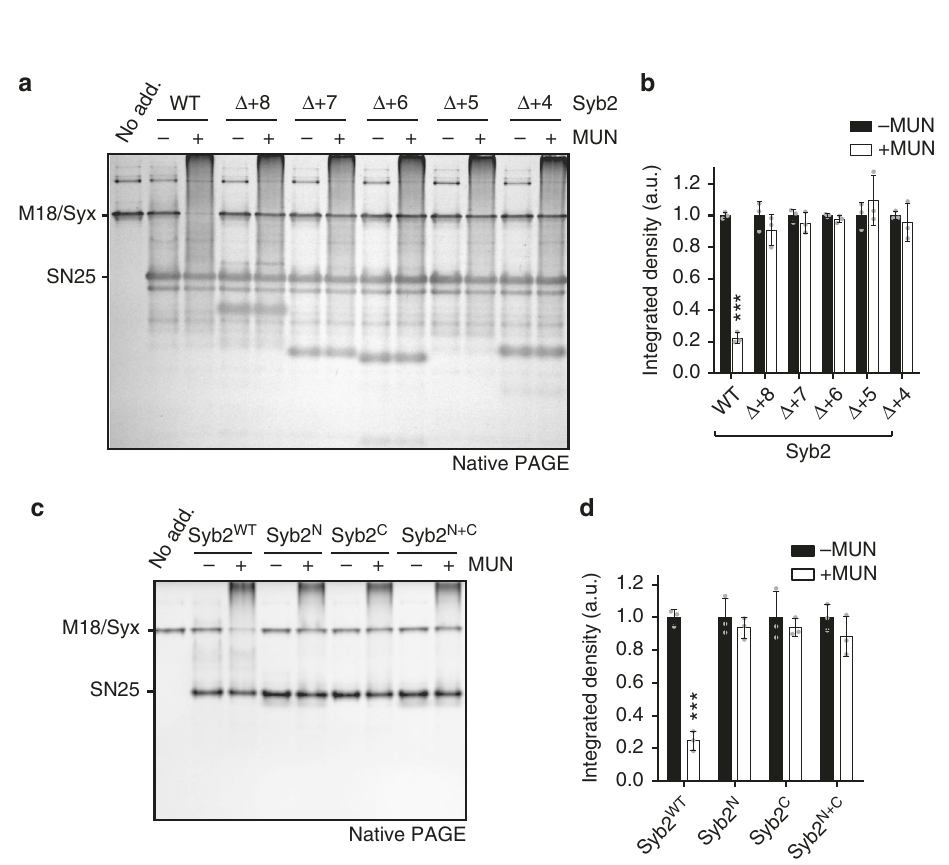
Fig. 1 A half-zippered SNARE assembly gates the transition. a Crystal structure of the SNARE complex (PDB entry: 3HD7). The lower panel displays the sequence of the SNARE motifs of Syx1, SN25, and Syb2. Hydrophobic binding layers − 7 to + 8 are indicated by rainbow-colored sticks in the upper panel and shaded in gray in the lower panel. b Scheme of the native PAGE assay for monitoring MUN-catalyzed transition from the Munc18-1/Syx1 complex to the SNARE complex. The Munc18-1/Syx1 complex (2 μ M) displays a sharp band at the top of the gel; upon the addition of the MUN domain (30 μ M), SN25 (10 μ M), and Syb2 (10 μ M), this band disappears with the formation of the SNARE complex. c Standard examples of the native PAGE assay. The Munc13-1 MUN domain, Munc18-1, or free Syb2 show smeared band; free Syx1 displays multi-bands that likely represent different assembly/aggregation states; SN25 shows a strong and clear band; Syx1 bound to Munc18-1 exhibits a strong and clear band. * indicates a putative non-productive aggregation of the Munc18-1/Syx1 complex. # indicates putative SNARE assembly intermediates that coexist with the actual ternary SNARE complex (lane 14). Disappearance of the Munc18-1/Syx1 complex can only be detected when all components are included (lane 14). Lane numbers are indicated at the top of the chart. d Effects of Syb2 N-terminal mutations or truncations on MUN-catalyzed transition from the Munc18-1/Syx1 complex to the SNARE complex using native PAGE. The representative gel displayed is one of three replicates. e Quanti fi cation of d . Integrated density represents the normalized integrated gray level of each assessed Munc18-1/Syx1 band. Data are presented as the means ± SD, n = 3, two-tailed t test, *** p < 0.001. f Effects of SN25 C-terminal truncations on MUN-catalyzed transition from the Munc18-1/Syx1 complex to the SNARE complex using native PAGE. The representative gel displayed is one of three replicates. g Quanti fi cation of f . Integrated density represents the normalized integrated gray level of each assessed Munc18-1/ Syx1 band. Data are presented as the means ± SD, n = 3, two-tailed t test, ** p < 0.01; *** p < 0.001. Source data are provided as a Source Data fi le